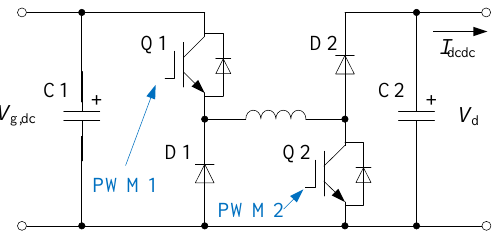
Fig. 3. Buck-boost DC-DC converter: C1, C2 – input and output filters; Q1, Q2 – power switches; D1, D2 – power diodes; L1 – inductor; V g,dc – wind generator rectified voltage; V d – DC bus voltage; I dcdc – current from the DC- DC converter.